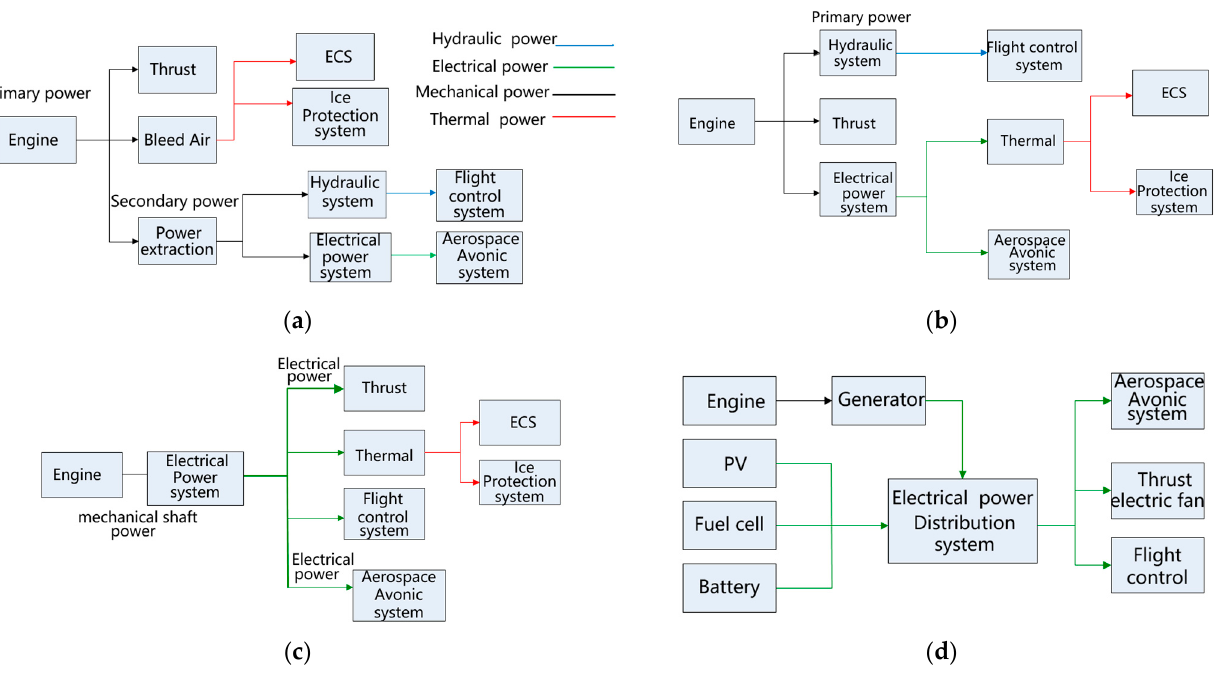
Figure 1. ( a ) The traditional architecture of aircraft power systems; ( b ) The more electric architecture of aircraft power systems; ( c ) The all-electric and electrical propulsion architecture of aircraft power systems; ( d ) The unmanned air vehicle or small size aircraft integrated with renewable energy power source.